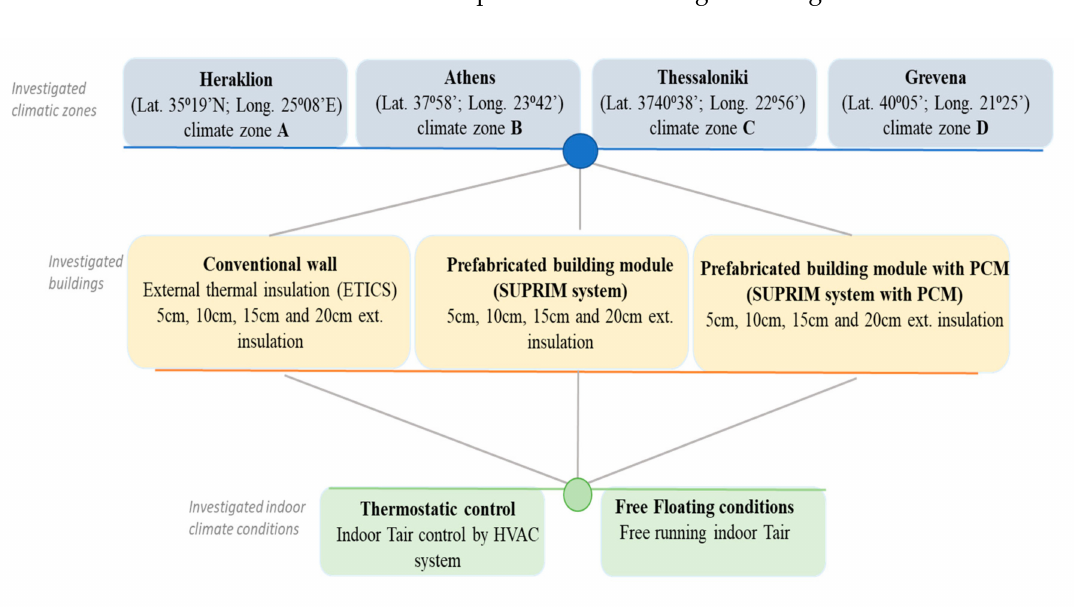
Figure 4. Examined simulation scenarios involving climatic conditions, building typologies, and control of indoor